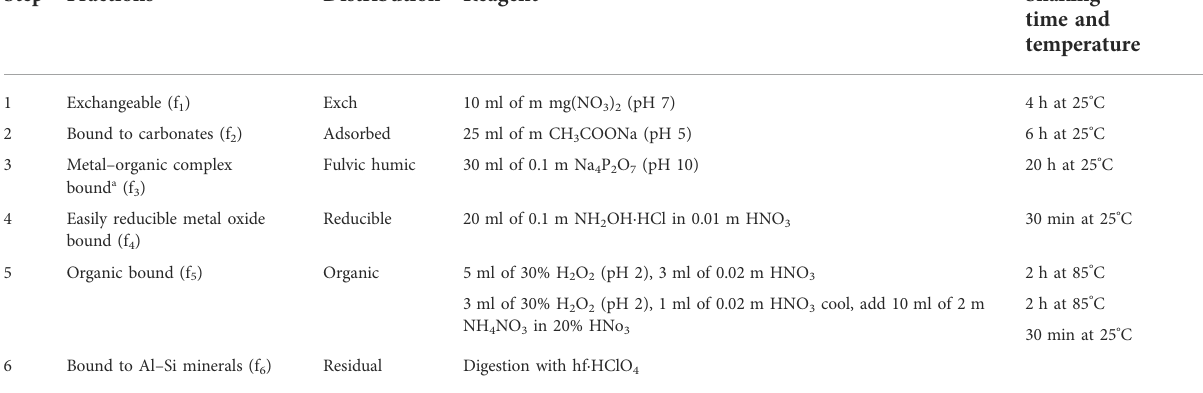
TABLE 1 Multistep selective sequential extraction scheme for heavy metals in the